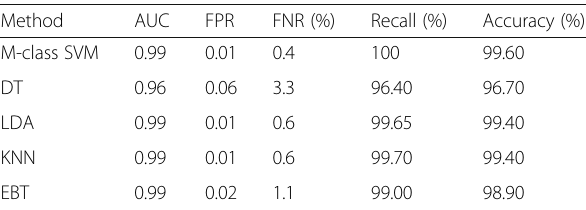
Table 8 Comparison of the proposed human classification algorithm with existing methods